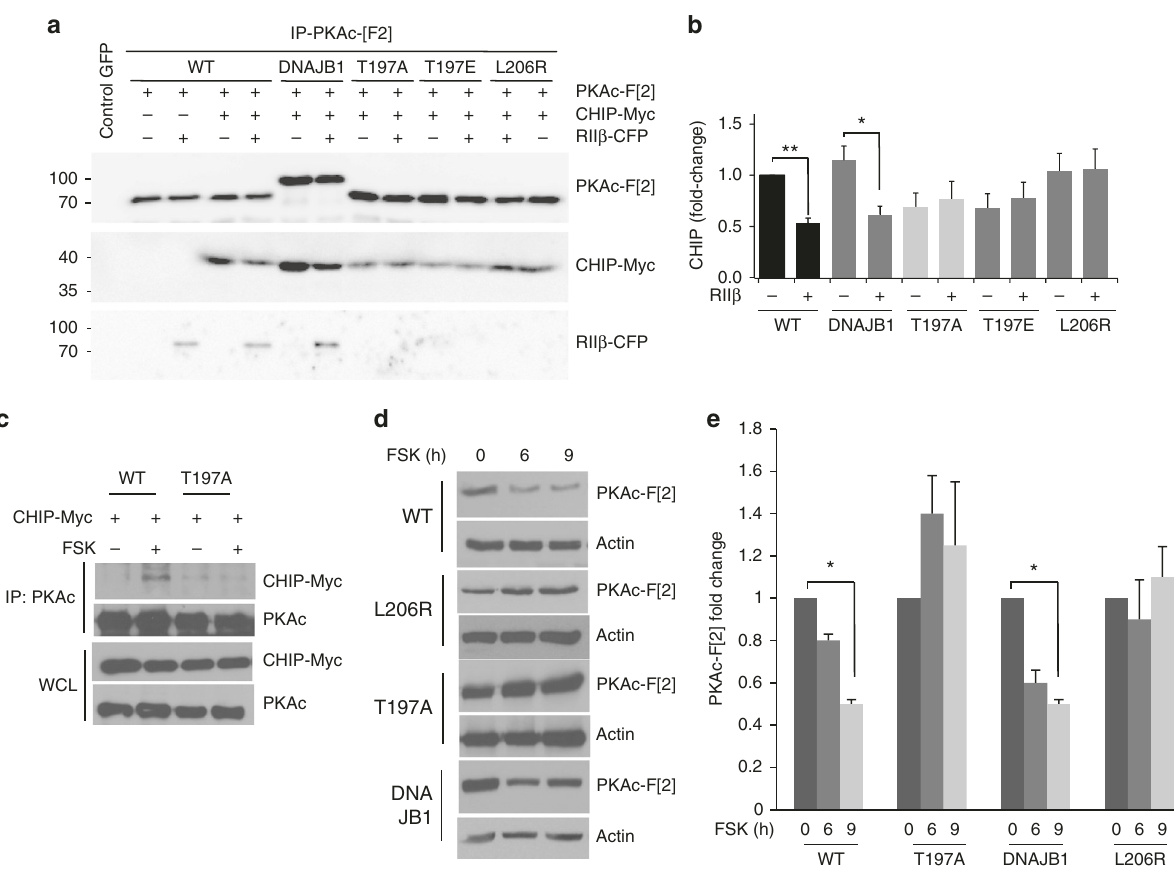
Fig. 3 cAMP regulation of PKAc:CHIP complex. a Impact of the PKAc mutation on CHIP binding. Cells co-transfected with RII β -CFP, CHIP-myc and several mutants of PKAc fused to the R luc PCA Fragment 2 (PKAc-[F2]) were lysed and subjected to immunoprecipitation using Rluc 4400 antibodies. Immunocomplexes were immunoblotted with the indicated antibodies. b Densitometric evaluation of the Fig. 3a signals. Statistical analysis of fi ve independent experiments is shown. Mean± SEM. Student ’ s t test,, * p < 0.05, ** p ≤ 0.01). c Cells transiently transfected with the indicated PKAc vectors were left untreated or stimulated with FSK. Lysates were immunoprecipitated with Rluc 4410 speci fi c antibody and immunoblotted with anti-PKAc and anti-Myc antibodies. d Cells transiently transfected with the indicated PKAc vectors were left untreated or stimulated with FSK. Lysates were immunoblotted with anti-PKAc and anti Actin antibodies. e Quantitative analysis of the experiments shown in d . A mean value ± S.E.M of three independent experiments is shown. Student ’ s t test, * p <